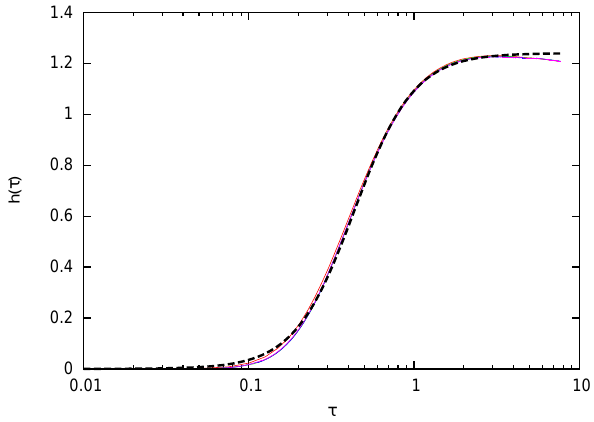
Fig. 5. h(τ) vs. dimensionless time τ for various initial geometric Fig. 5. h ( τ ) vs. dimensionless time τ for various initial geometric mean masses and sublimation rates: m 0 = 1ng, a =− 0 . 04 (red); mean masses and sublimation rates: m 0 = 1 ng, a = − 0 . 04 (red); m 0 = 10ng, a =− 0 . 09 (green); m 0 = 100ng, a =− 0 . 2 (blue); m 0 = 10 ng, a = − 0 . 09 (green); m 0 = 100 ng, a = − 0 . 2 (blue); m 0 = 1000 ng, a = − 0 . 5 (violet). These curves are so similar m 0 = 1000ng, a =− 0.5 (violet). These curves are so similar that that only one can be seen. The dashed black line is a generalized only one can be seen. The dashed black line is a generalized log– log–logistic function that fits h ( τ ) . logistic function that fits h(τ)